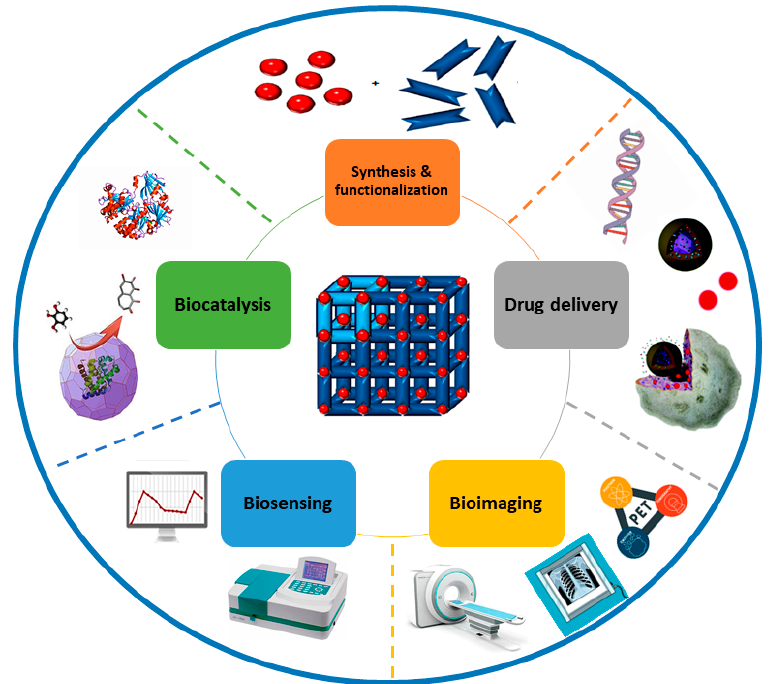
Figure 7. Biomedical applications of MOFs.